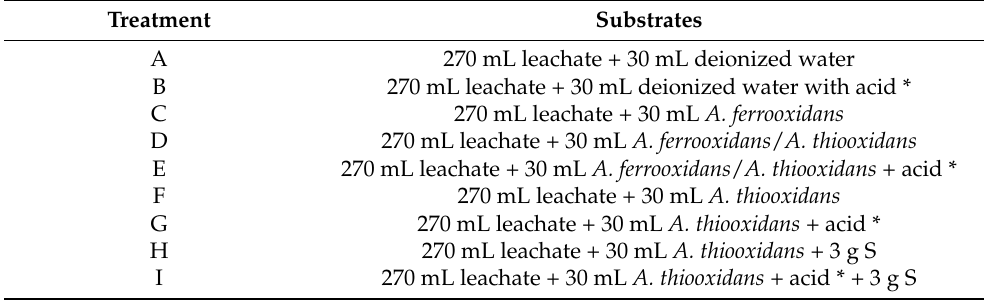
Table 4. Combinations analyzed in Stage I and Stage II based on the use of landfill